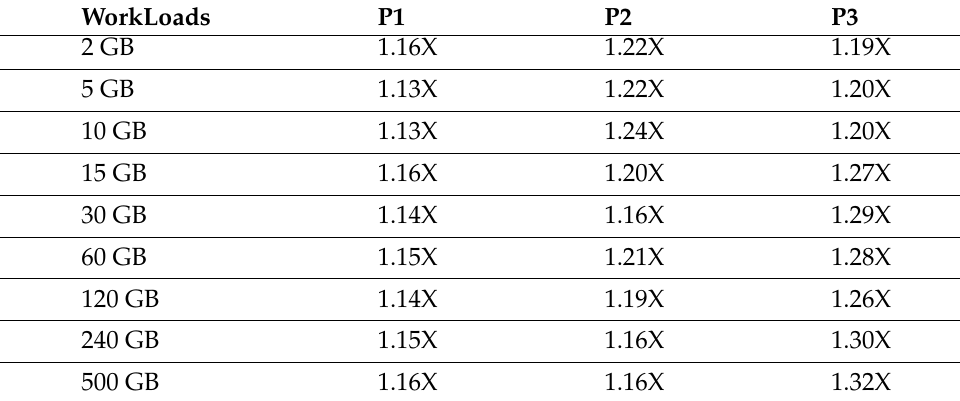
Table 3. Latency comparison results for P1, P2, and P3 applications under various workloads on s2p-flink and native Flink.